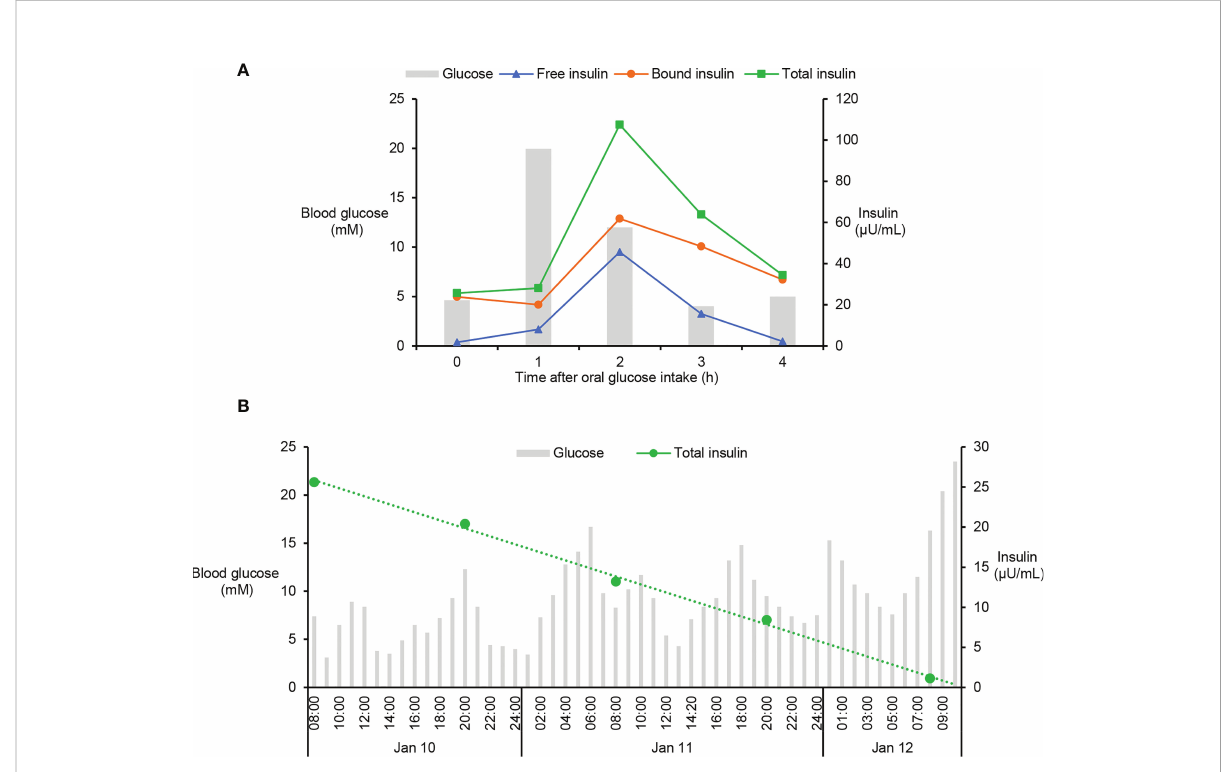
FIGURE 2 Fluctuation of blood glucose and serum insulin levels in oral glucose tolerance test and insulin withdraw study. (A) Oral glucose tolerance test was performed in this patient by oral ingestion of 75g of glucose preceded by an overnight fast and levels of blood glucose and serum insulin were measured at 0, 1, 2, 3, and 4h after glucose ingestion. Levels of free and total insulin were measured using the methods as described in Figure S2. Bound insulin was calculated by subtracting free insulin from total insulin. (B) After careful depletion of subcutaneous insulin, the patient was stabilized on intravenous insulin which was then discontinued. Blood glucose and serum insulin were monitored in the following time until the patient had sustained extreme hyperglycaemia, the sign of exhausted injected insulin. Total insulin was measured using the method as described in Figure